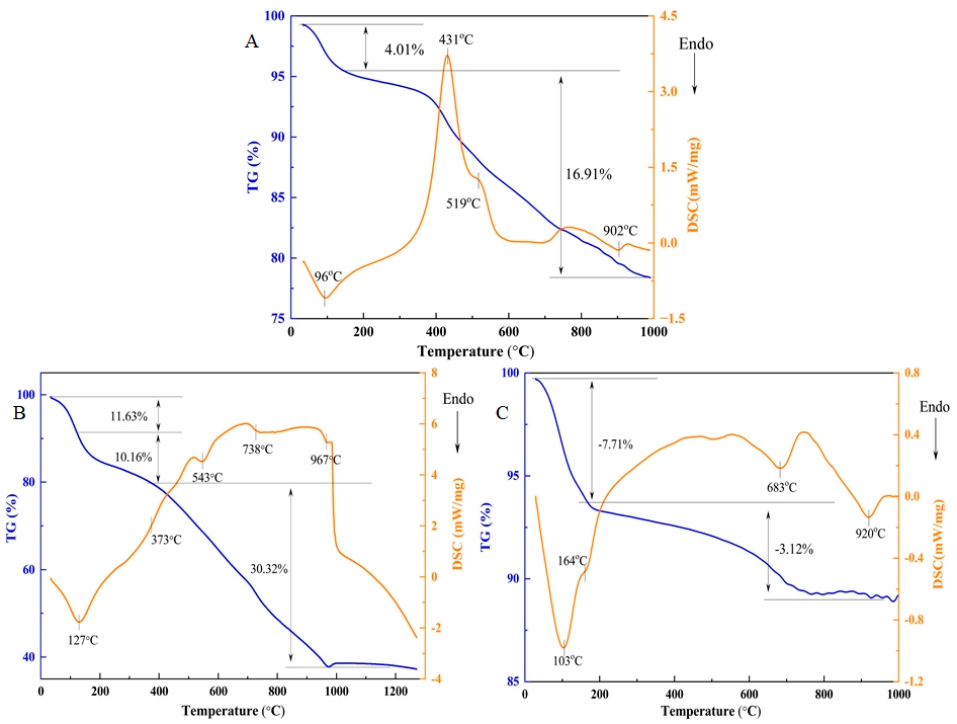
Figure 7. TG-DSC results of ( A ) HAMB, ( B ) MHA, and ( C ) bentonite. Combined with the TG-DSC analysis curve of bentonite and HAMB binders shown